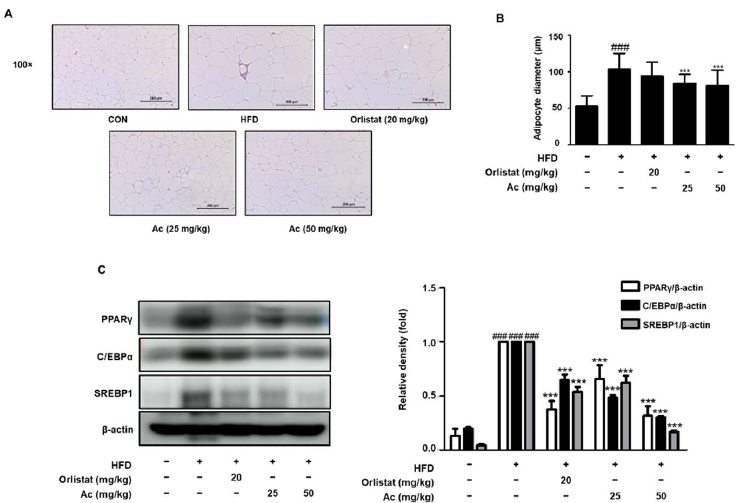
Figure 3. Effect of Ac on the adipose tissue expansion and adipogenic transcription factors in eWAT of HFD-induced mice. ( A ) Representative images stained with H&E in eWAT. Scale bar is 200 µm. ( B ) The average diameter of adipocytes in eWAT. ( C ) The protein level of PPARγ, C/EBPα, and SREBP1 in eWAT analyzed by western blot analysis. Densitometric analysis was performed using ImageJ v1.50i. Data are expressed as the mean ± SD of three independent experiments. ### p < 0.001 vs. chow diet-fed group; *** p < 0.001 vs. only HFD-fed